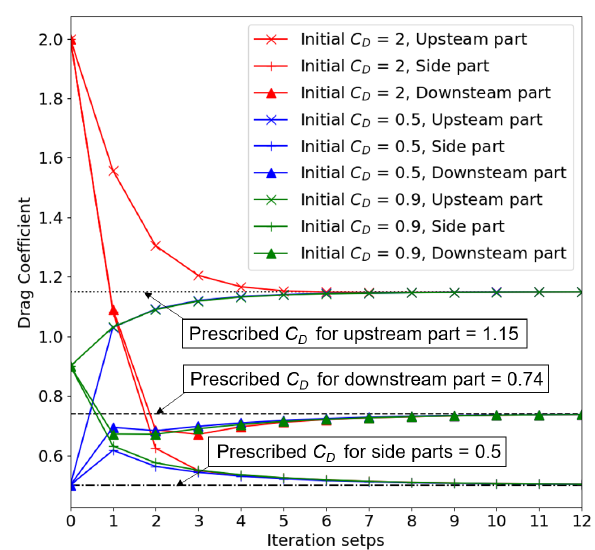
Figure 10: Drag coefficients identified by the PID reg- ulators for the 4-panel